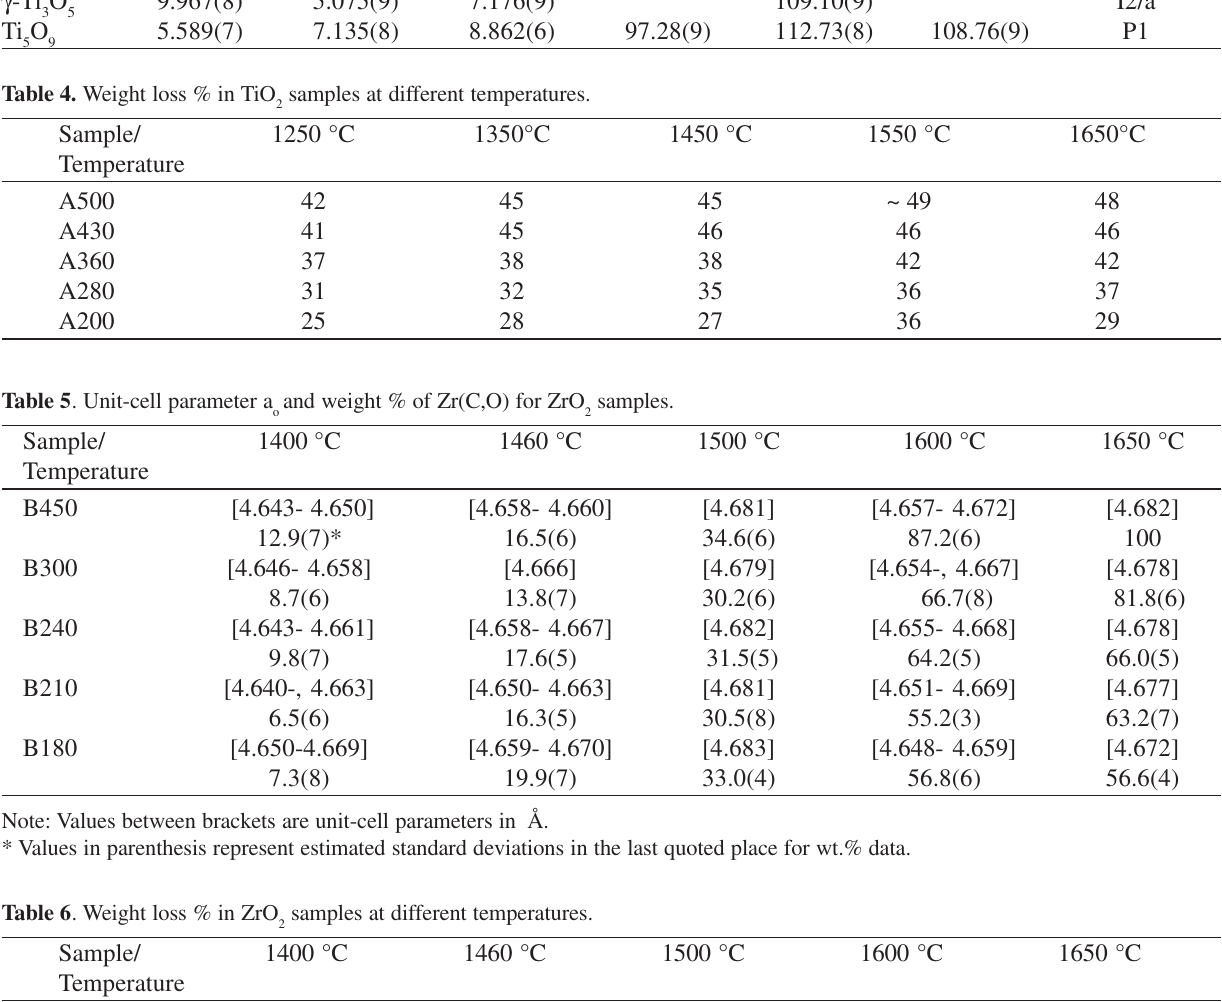
Table 6 . Weight loss % in ZrO